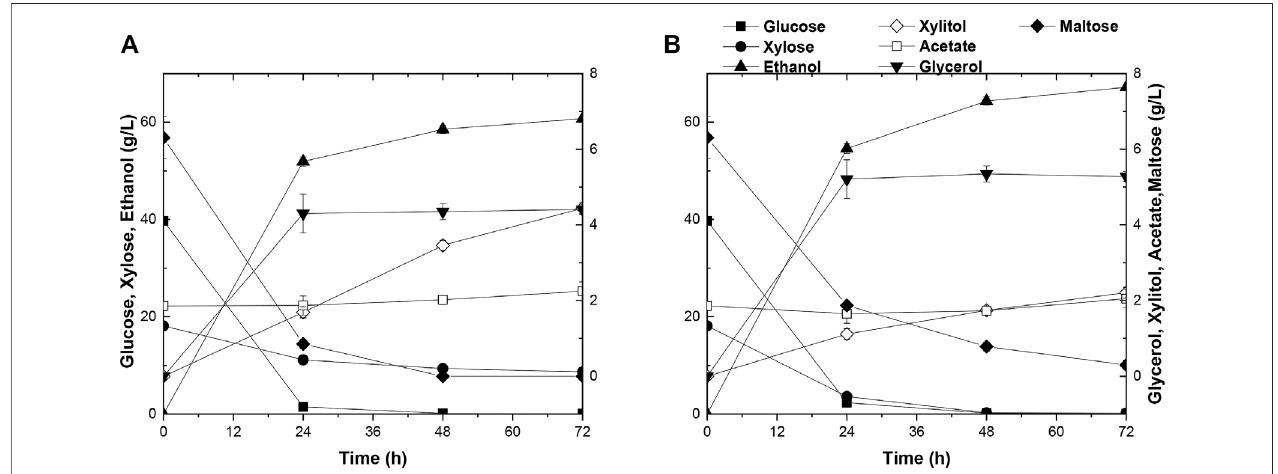
FIGURE6| Time-dependentfermentationofAngelandA31Z.Fermentationpro fi leofAngel (A) andA31Z (B) inSSCFexperiments.Diluteacidpretreatmentofcorn straw with 24% dry matter concentration and equal mass mixture of corn starch with 24% dry matter concentration were used as substrates for yeast